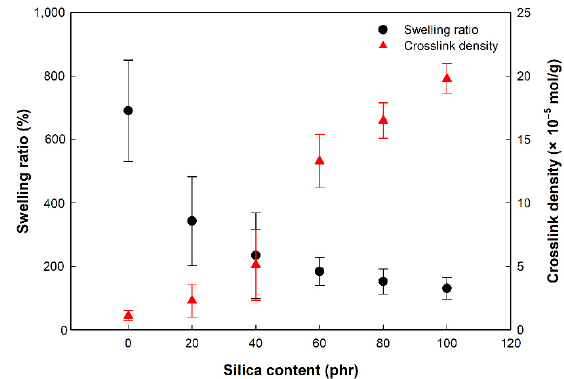
Figure 2. Swelling ratio and crosslink density of EPDM/silica vulcanizates.